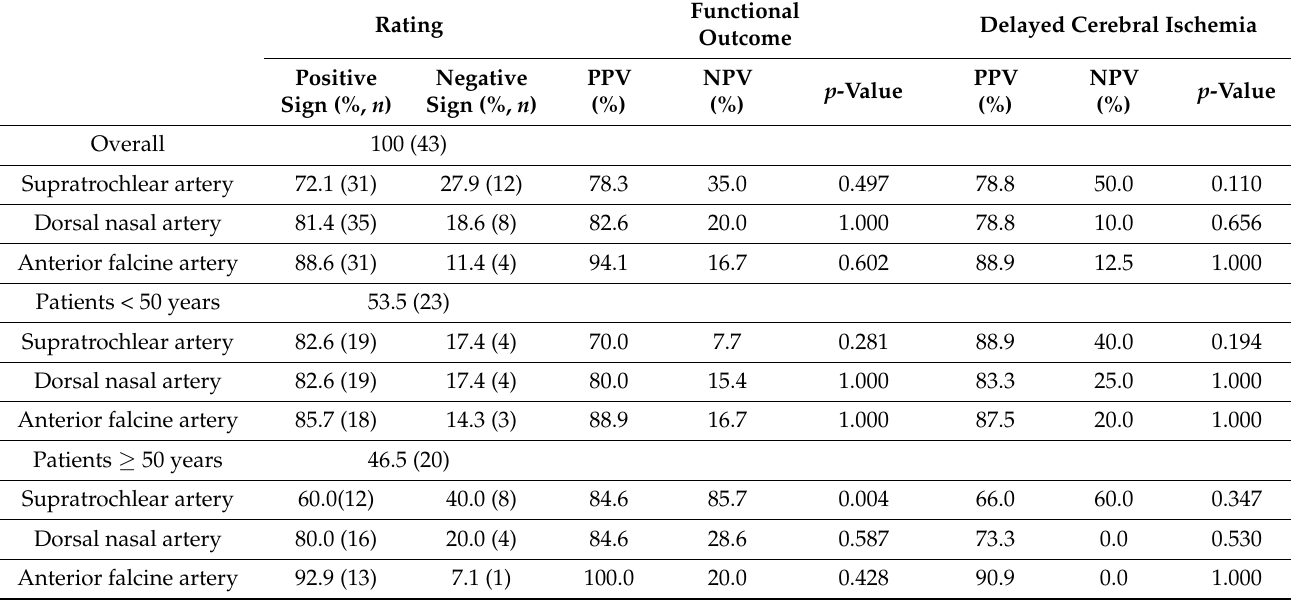
Table 3. Vessel signs in cerebral